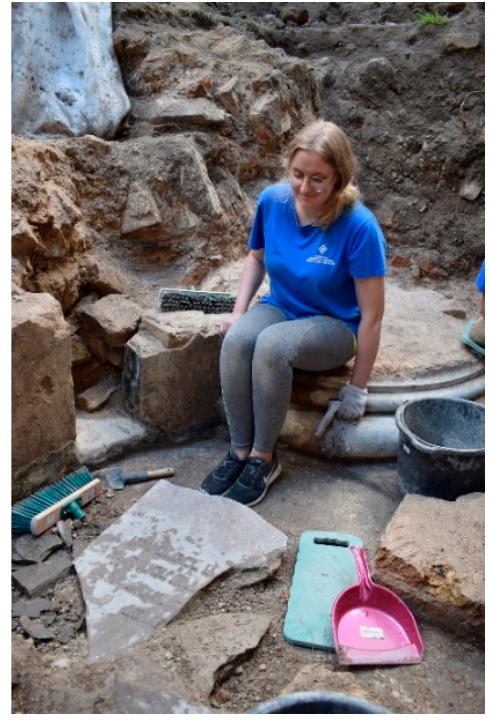
Figure 9. Discovery of a section of the inscribed slab on the floor of the bimah loge. Photo: Jon Seligman, Israel Antiquities